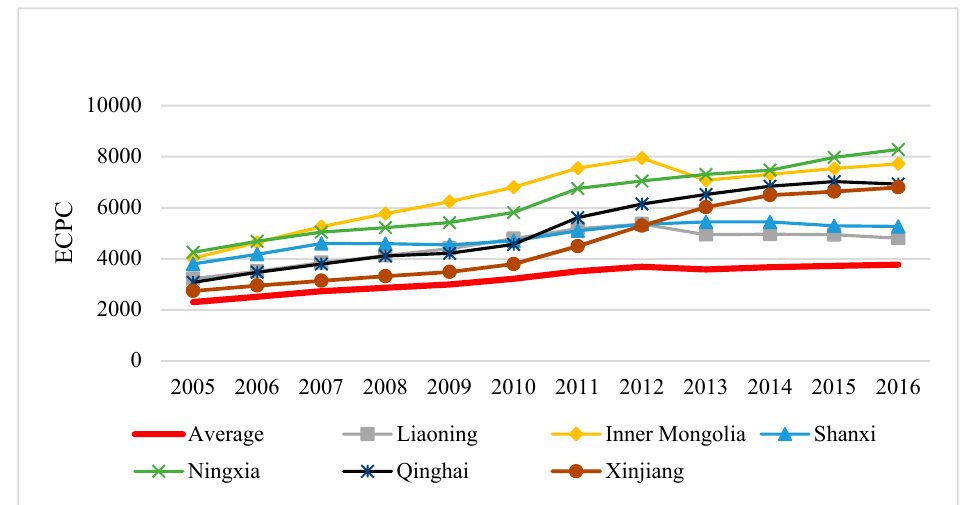
Figure 3. Per capita energy consumption (ECPC) of high EIWB provinces in 2005–2016.